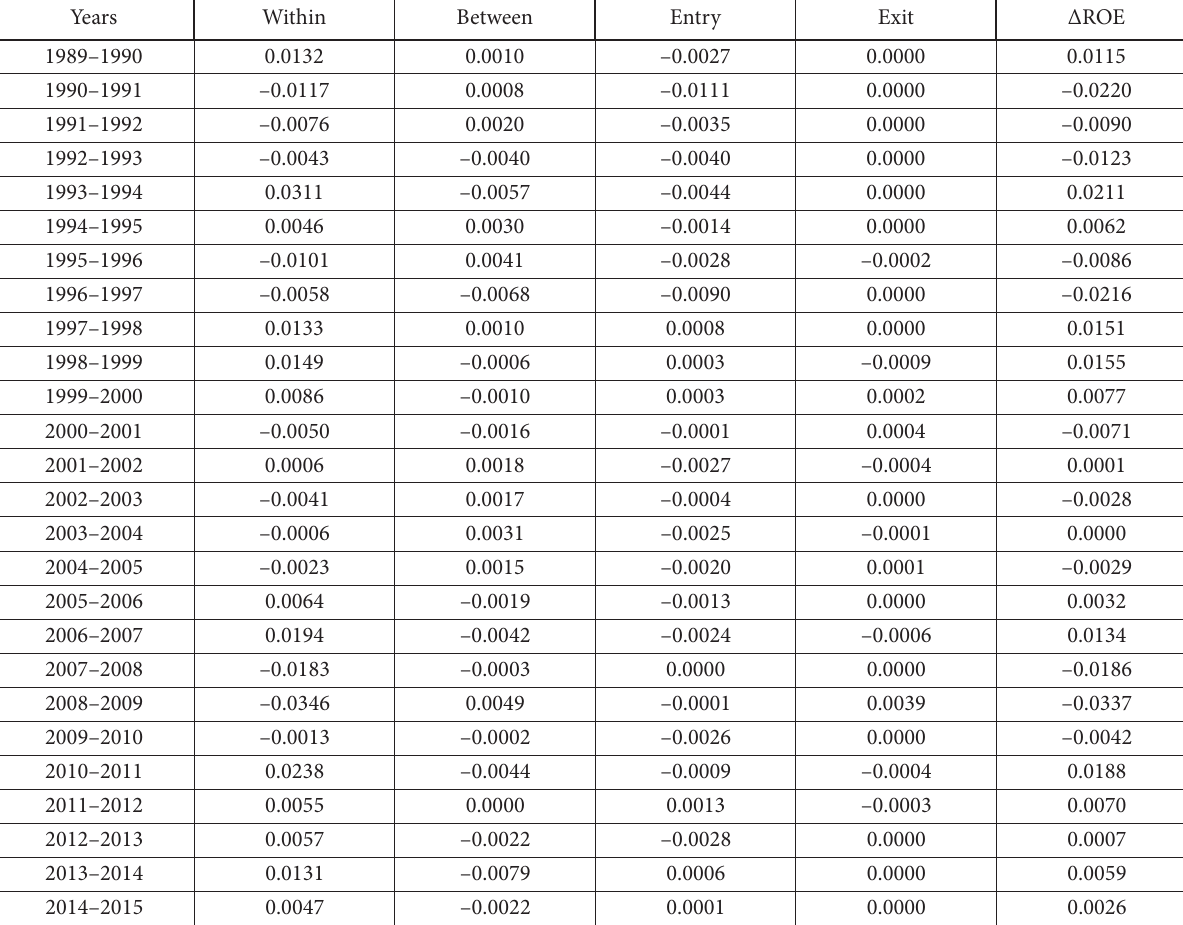
Table 3. Evolution of the Bennet dynamic decomposition, funds from operations-based ROE changes: 1989–2015 Years Within Between